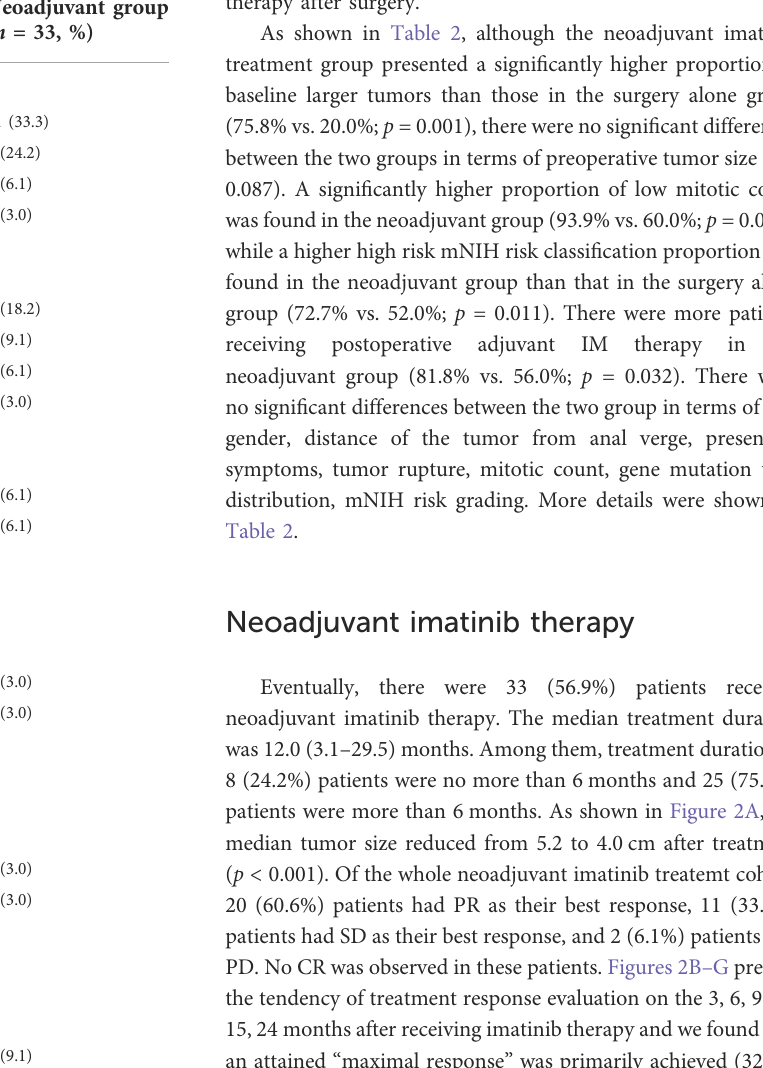
TABLE 3 Summary of neoadjuvant imatinib treatment-related adverse